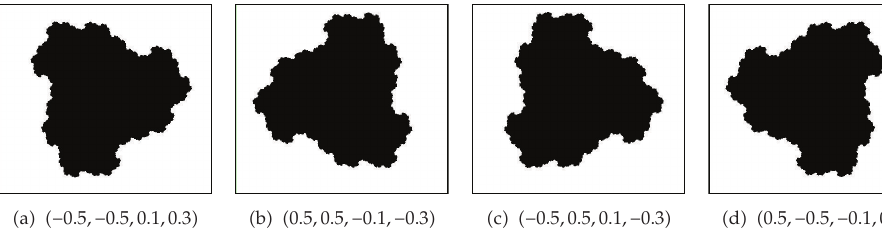
Figure 7: The generalized J sets perturbed by additive noise when α (cid:6) 3.